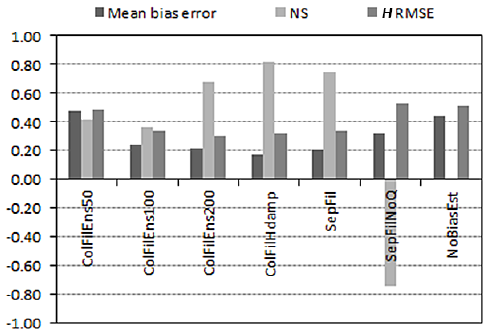
Figure 2. Mean bias error, NS and H RMSE for the years 1971– 1972 in the synthetic